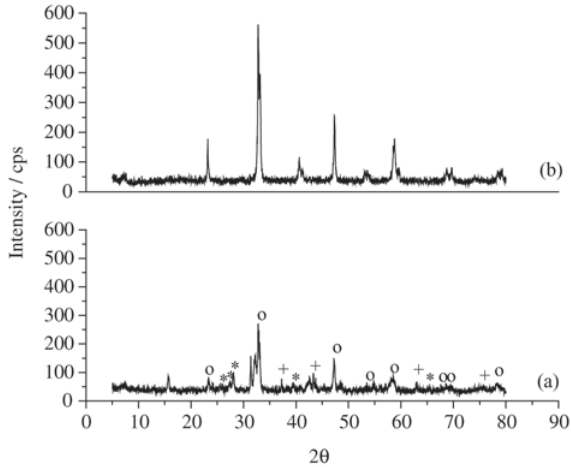
Figure 1. XRD diagrams of LaNiO for 10 h. a) method 1; b) method 2. o: LaNiO